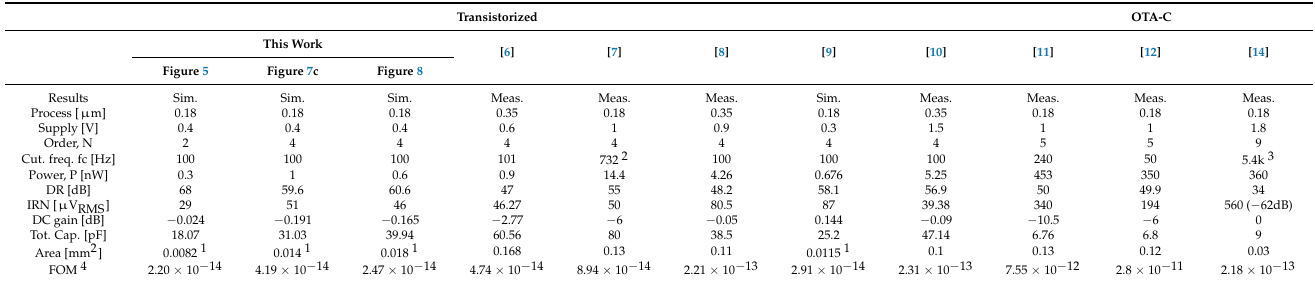
Table 3. Low-frequency filter performance